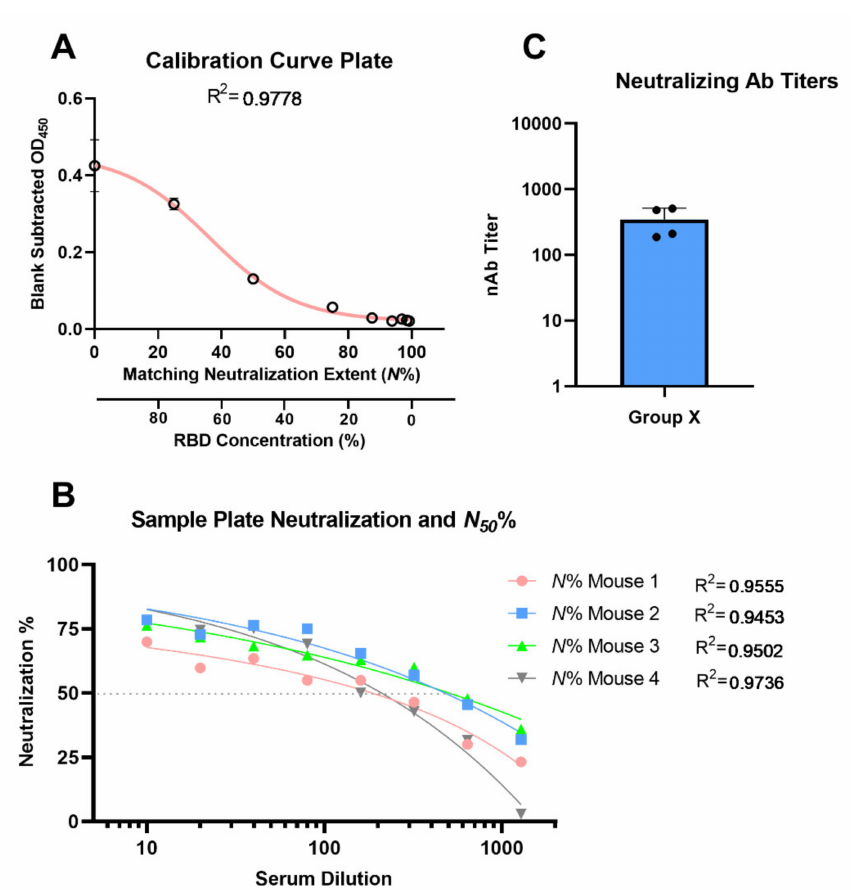
Figure 9. Depicting results of CC- and S-plate using the calculation sheet, fitting of calibration curve replicates to sigmoidal function ( A ), fitting of individual mice serum neutralization N % (of RBD-ACE2 binding) as a function of serum dilution ( B ), and the resulting mean group nAb titer column graph ( C